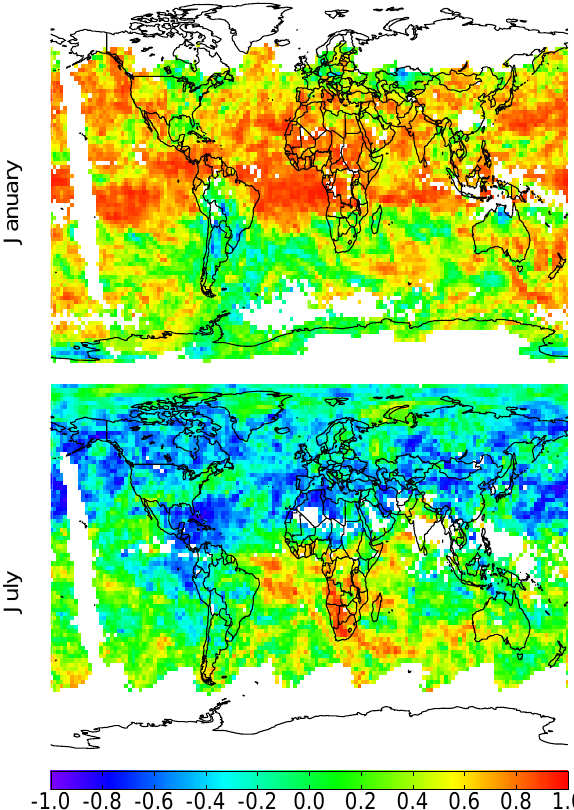
Fig. 4. CO 2 -CO model error correlation coefficients between col- umn CO 2 sampled with the land and ocean OCO averaging kernels of Fig. 1 and column CO sampled with actual AIRS averaging ker- nels associated with each scene. CO 2 and CO are sampled at 13:30 local time for January and July 2006 and error correlations are cal- culated by the paired-model (GEOS-5 vs. GEOS-4) method. Blank areas correspond to grid squares that had fewer than 21 AIRS ob- servations for the month.